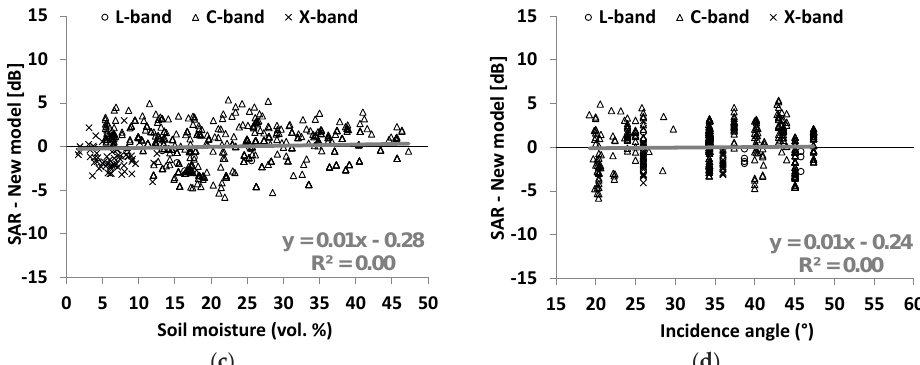
Figure 5. ( a ) Comparison between σ ◦ in the new model and σ ◦ measured (for all SAR bands) for HV polarization; ( b ) the difference between SAR and the new model as a function of kHrms ; ( c ) the difference between SAR and the new model as a function of mv ; and ( d ) the difference between SAR and the new model as a function of incidence angle. The best regression model is plotted in gray.